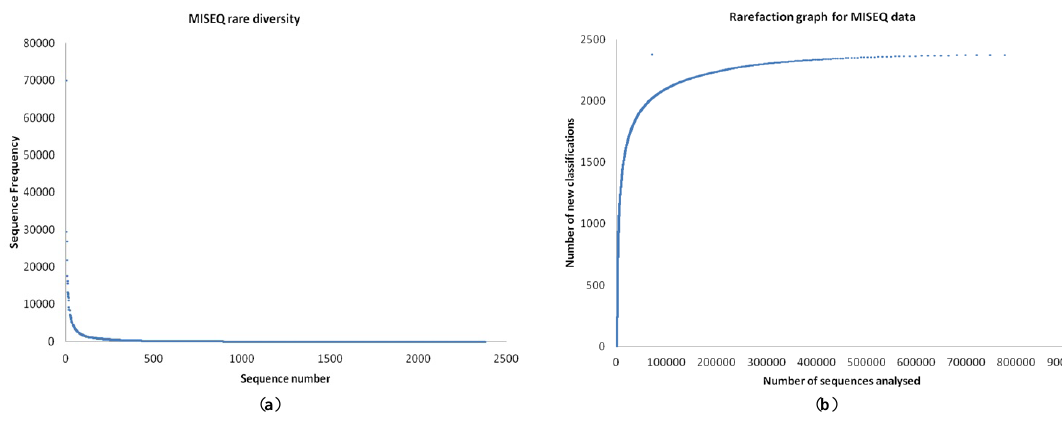
Figure 6. (a) Rare diversity and (b) rarefaction estimate based on MISEQ data analysed.